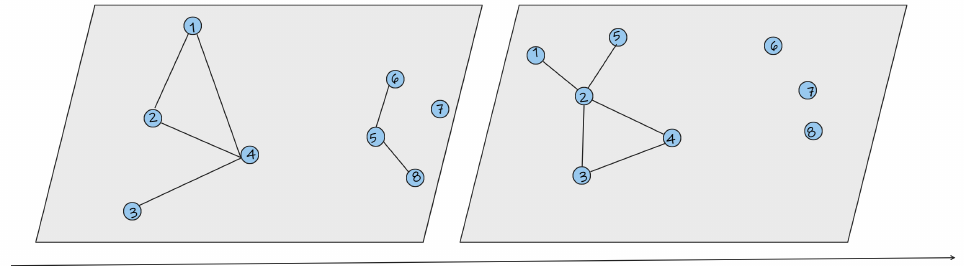
Figure 4. Illustration of complex-community detection